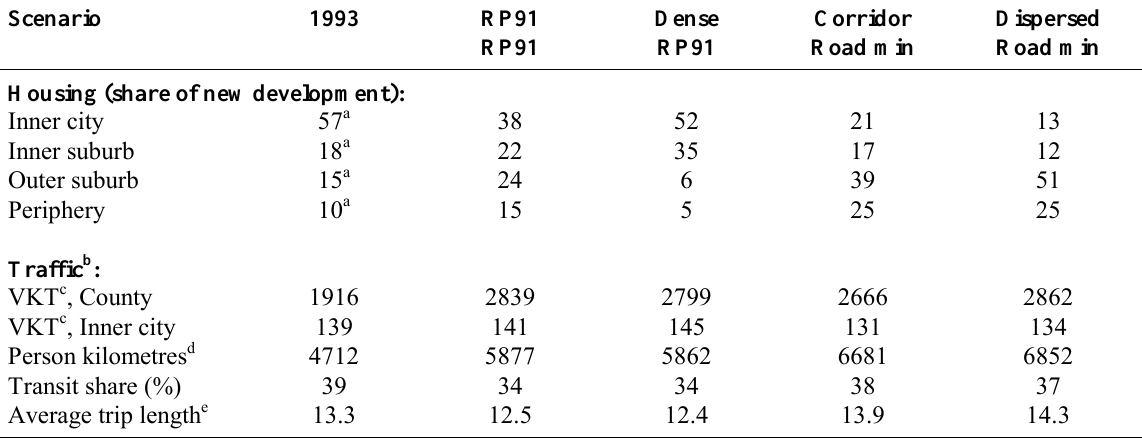
Table 3. Regional structures: impact of land-use/transport systems 2020 Scenario 1993 RP91